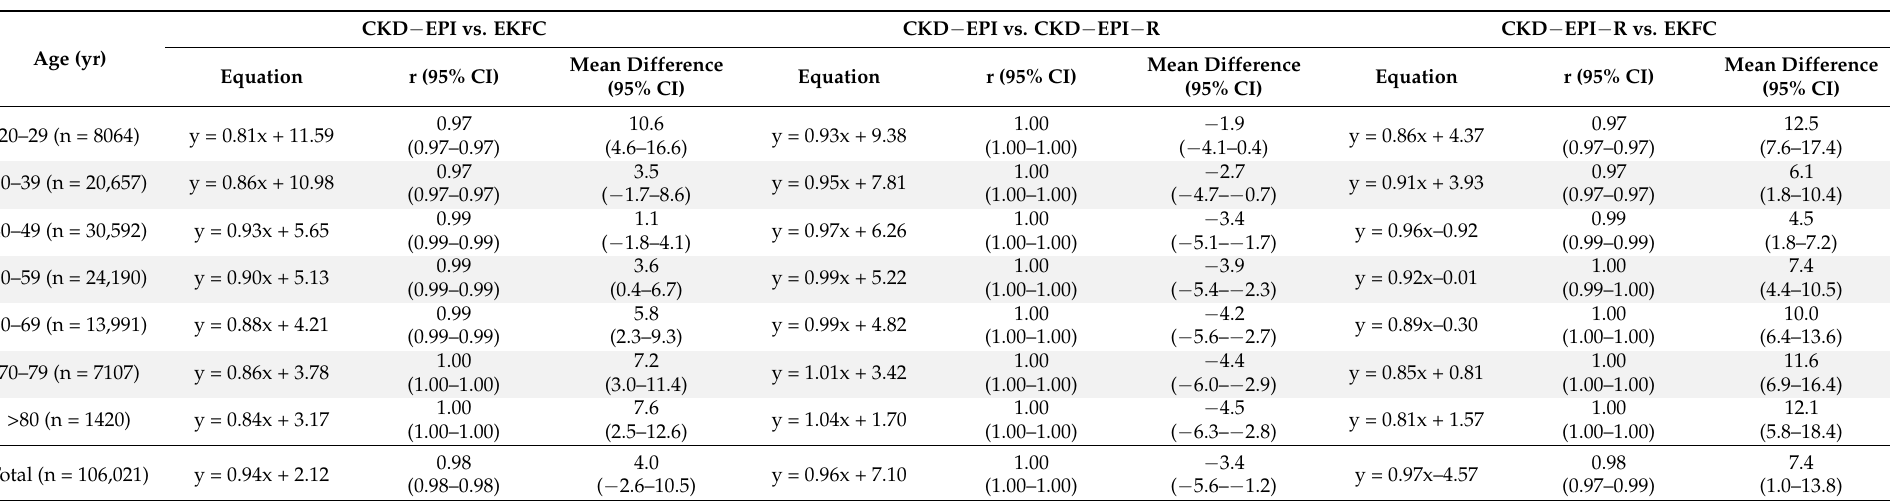
Table 1. Correlation and differences of eGFR among serum creatinine-based CKD-EPI, EKFC, and CKD-EPI-R equations stratified by age group.